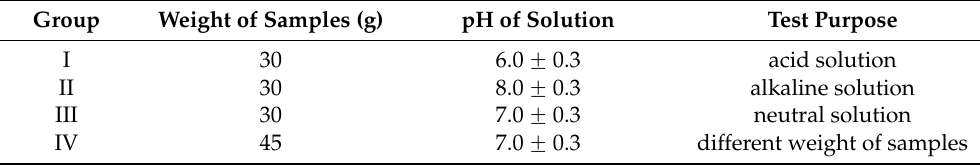
Table 1. Test setting data for the four column leaching experimental groups.